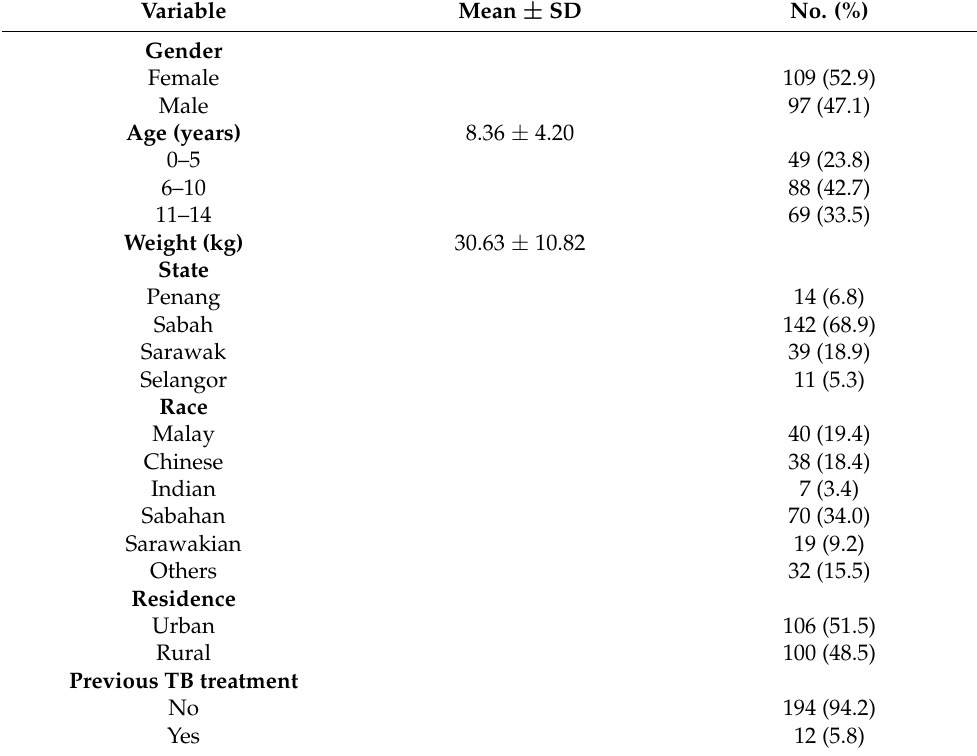
Table 1. Patients’ baseline sociodemographic and clinical